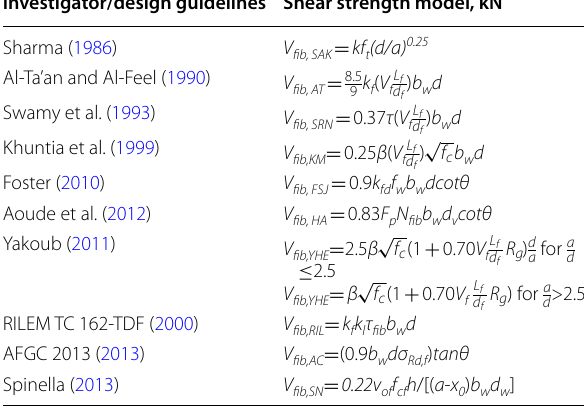
Table 9 Summary of a typical predictions of shear